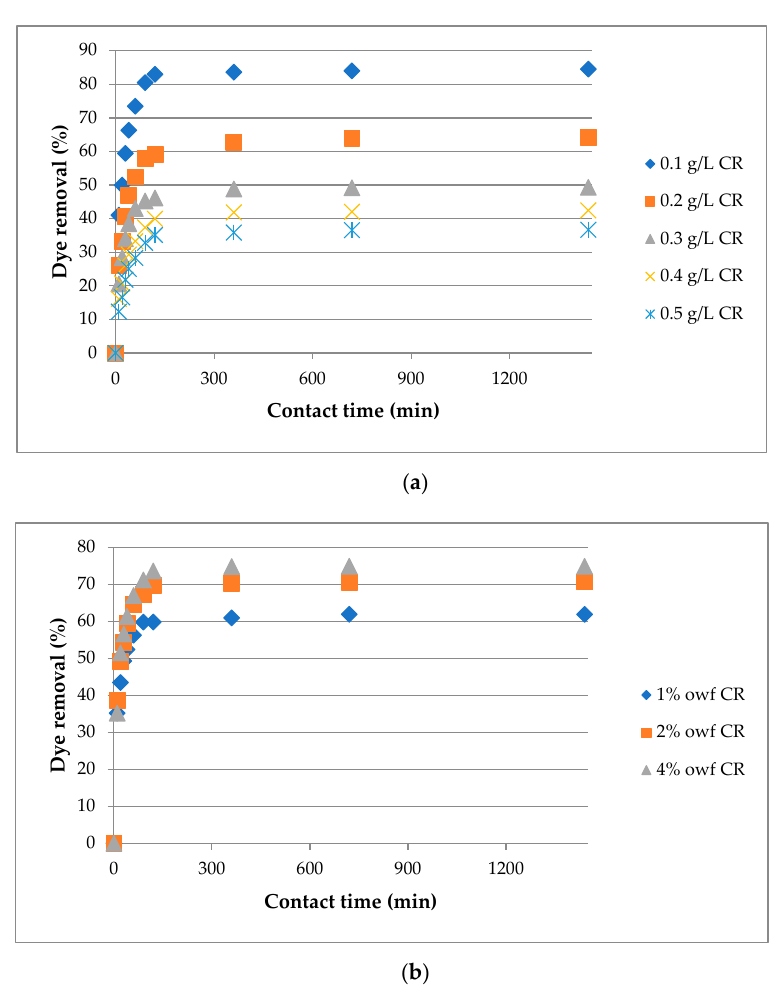
Figure 10. Dye removal vs. contact time of: ( a ) alkaline scoured S20_70/30 rice husk (adsorption conditions are 0.1 to 0.5 g/L Congo red (CR), 25 °C, 10 g/L rice husk) and ( b ) ERH (adsorption conditions are effluent from dyeing cotton with 1%, 2% and 4% (owf) initial concentration of CR, 90 °C initial temperature and 10 g/L rice husk).